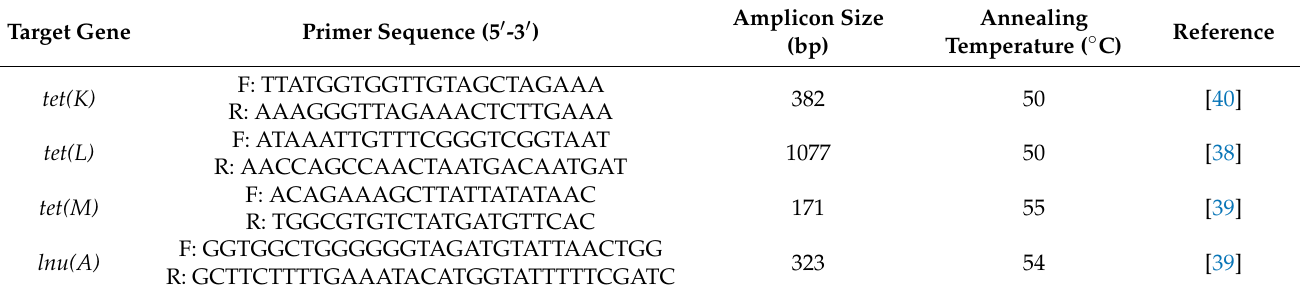
Table 1. Targeted resistance and toxin genes of C. perfringens and their primer sequences, expected amplicon sizes, and annealing